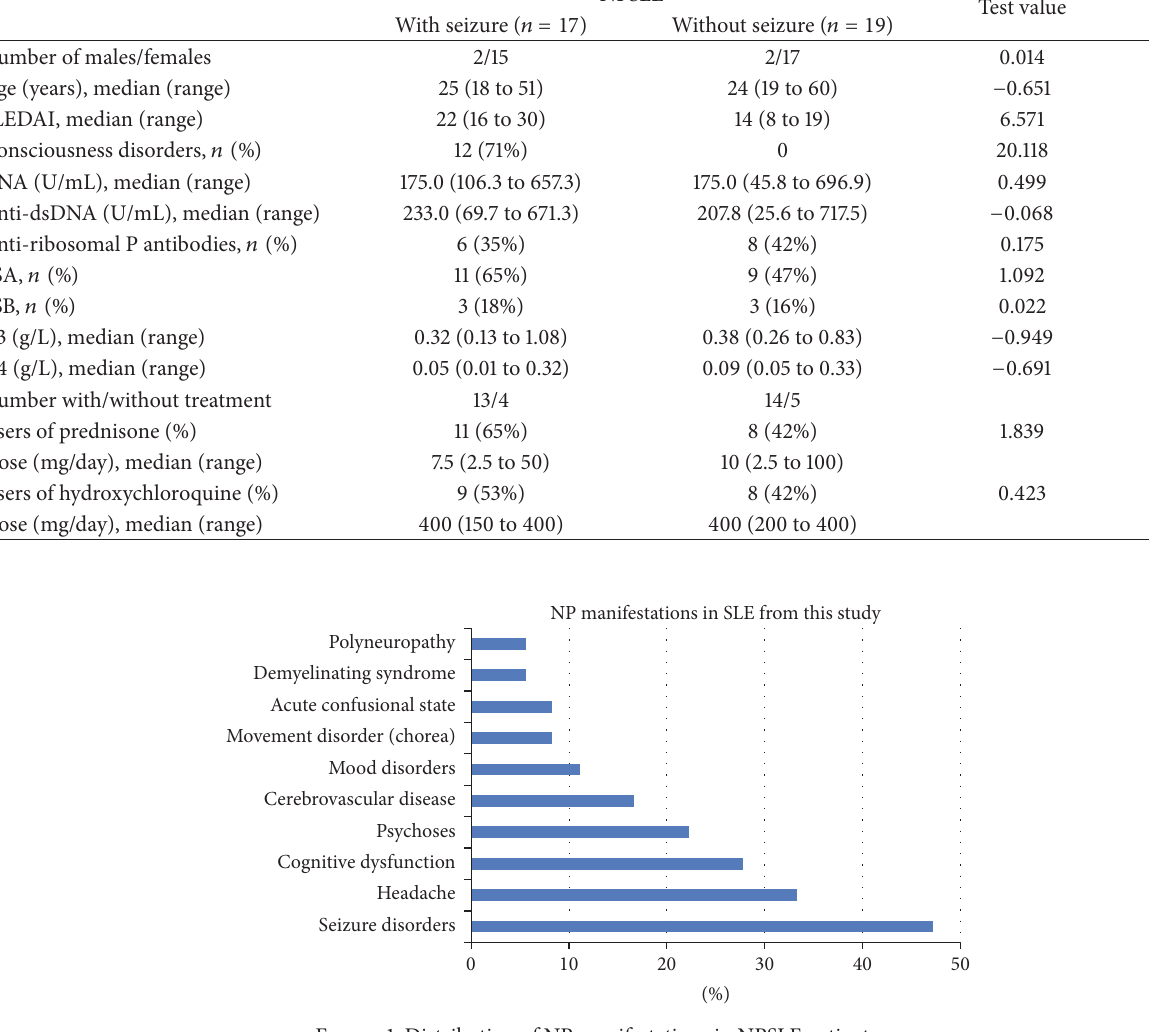
Figure 1: Distribution of NP manifestations in NPSLE